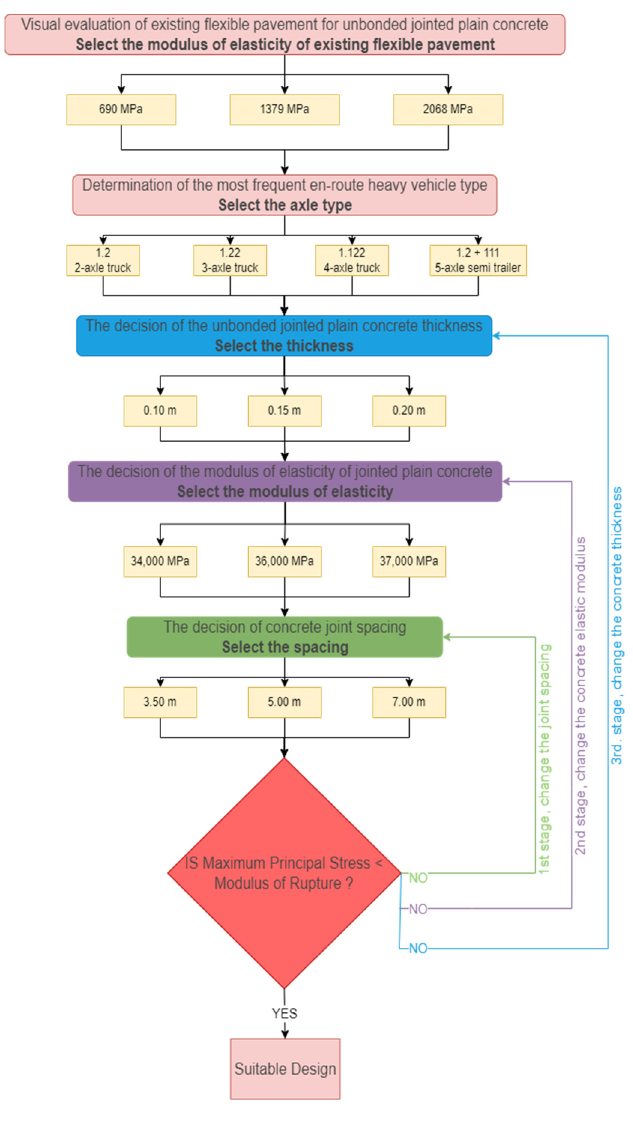
Figure 14. Pavement design flow chart.